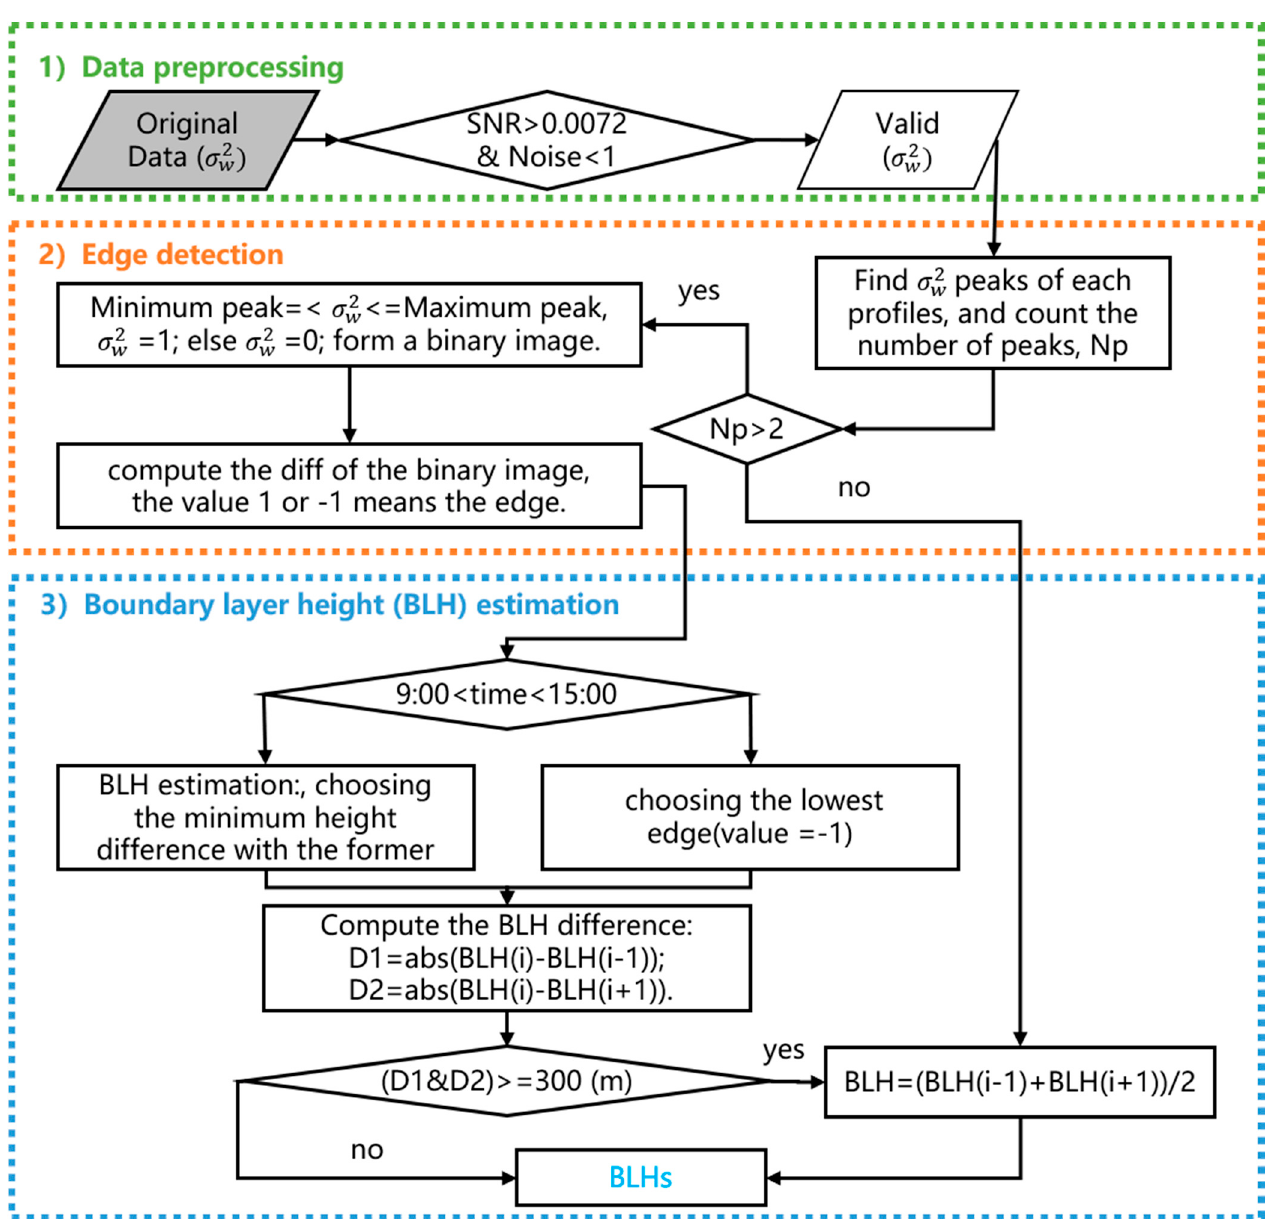
Figure 3. Flowchart for the ED method.